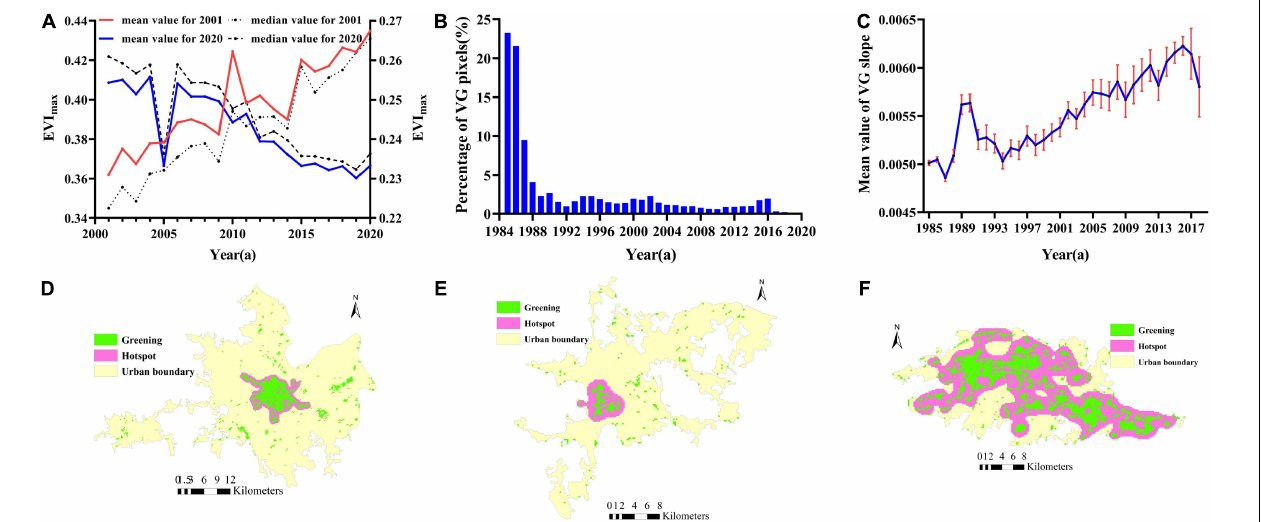
FIGURE 6 | Concentration types for the VG hotspots. (A) Mean and median of EVI max within the urban boundary for the year 1990 and 2020; (B) the percentage of VG pixels per AIA generation year; (C) the mean value of VG slope per AIA generation year; (D) center-type (Changzhou); (E) fringe-type (Changshu); and (F) infill-type (Baotou). TABLE 2 | Correlation coefficients for the changes in the AIA and VG. Pearson r Greening area Greening slope Horizontal trend Fragmentation and aggregation Vertical trend Area GDi GDDi PD LPI LSI AI